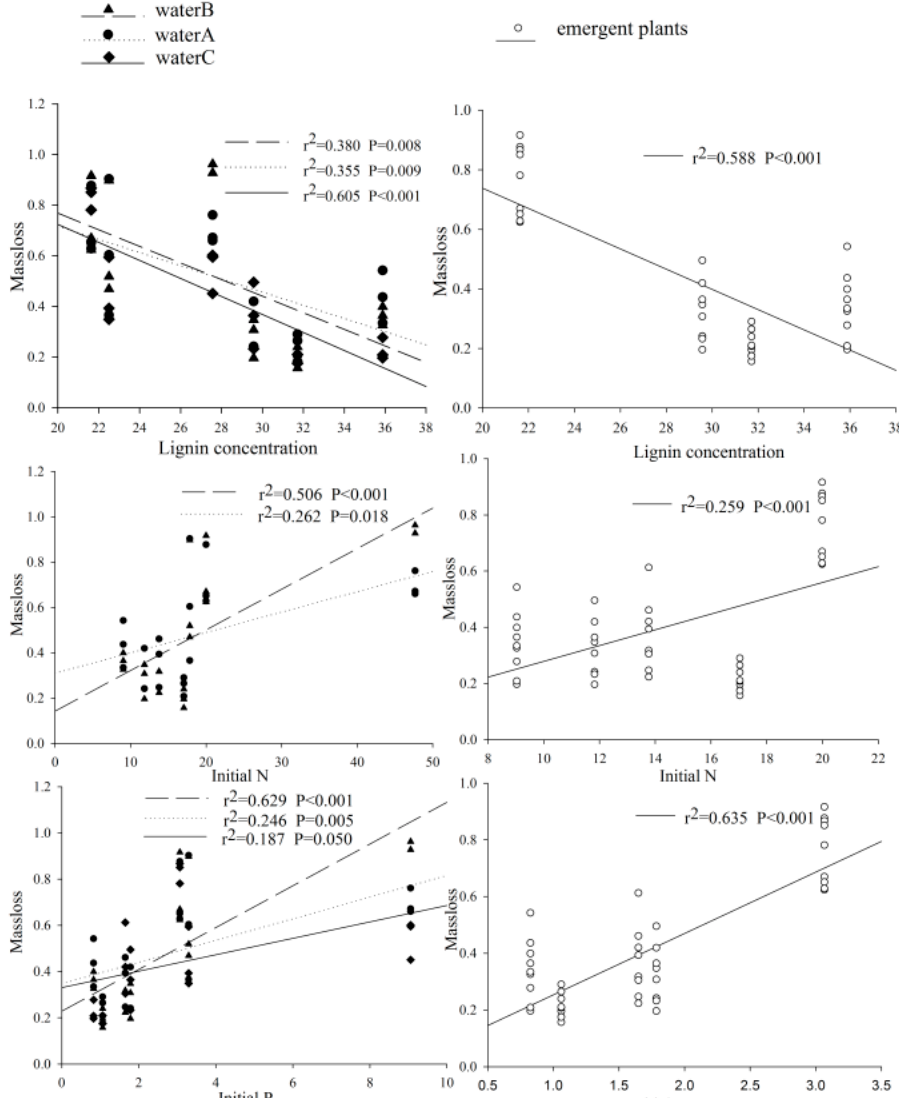
Figure 3. Relationship between initial litter quality (lignin concentration, TN and TP) and litter mass loss. Data points are shaped by water substrates or plant growth forms (A: polluted water, black circle; B: purified water by a constructed wetland, black triangle; C: natural tap water, black diamond; Emergent plants, white circle). Note that floating plants were not shown in the growth form figure due to the limited data points.